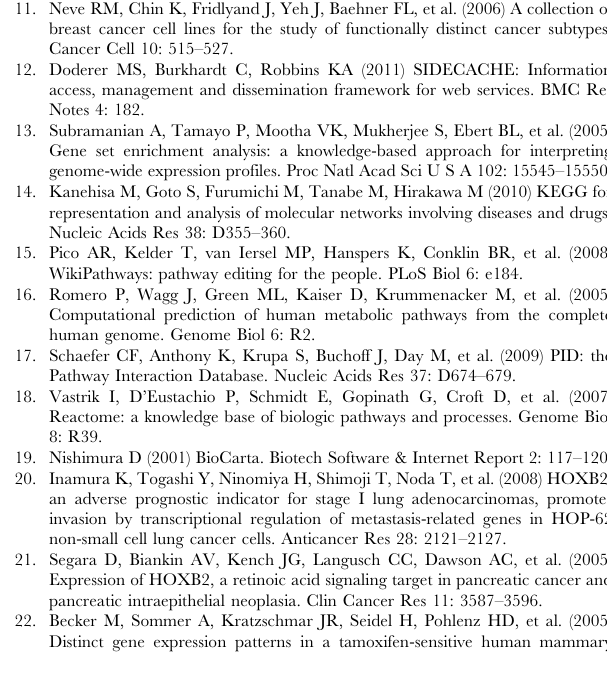
Figure S2 Extension of CMS applications: Discovery of tumor specific methylation profiles. CCDC81 has no significant difference between breast tumors and breast normal tissues, while it is hyper-methylated in endometrial tumors compared with endometrial normal tissues. Figure S3 Extension of CMS applications: Discovery of tumor specific methylation profiles. SOX11 was hyper- methylated in breast tumors compared with breast normal tissues, and was also hyper-methylated in endometrial tumors compared with endometrial normal tissues. Table S1 DMR regions of Breast and Endometrial cancers for HOXB2